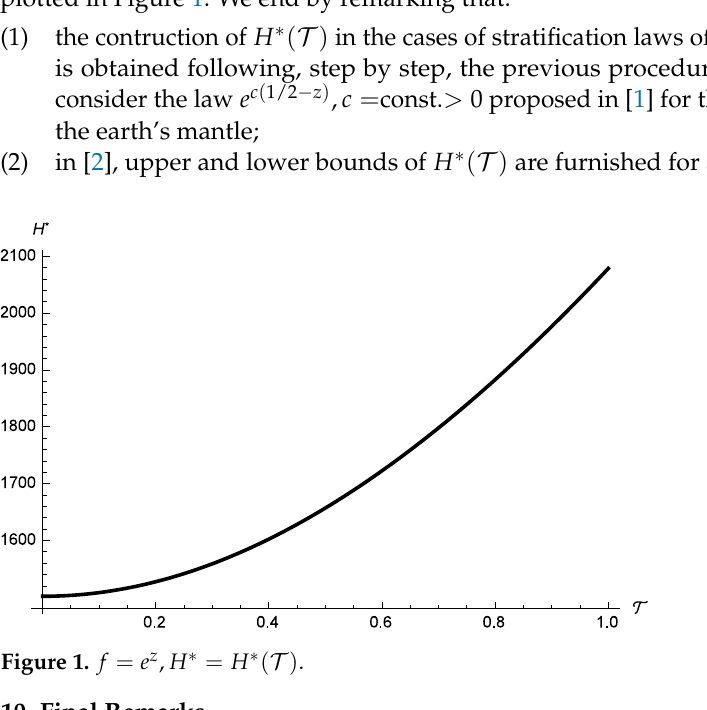
Figure 1. f = e z , H ∗ = H ∗ ( T )